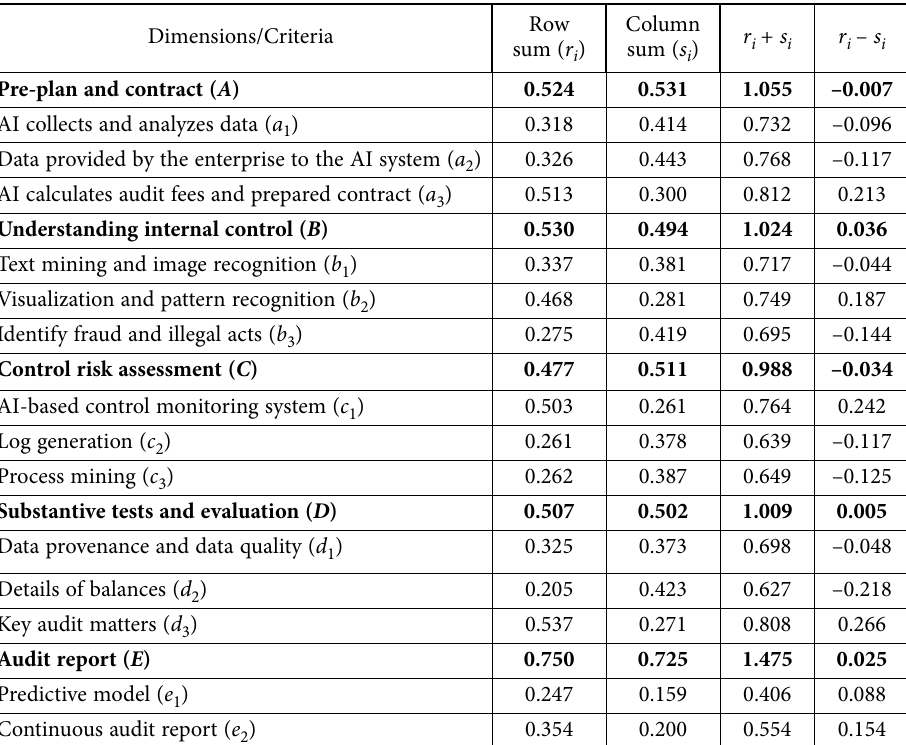
Table 5. Sum of cause ( r i )-effect ( s i ) relationships among the key dimensions (phases) and criteria (steps)